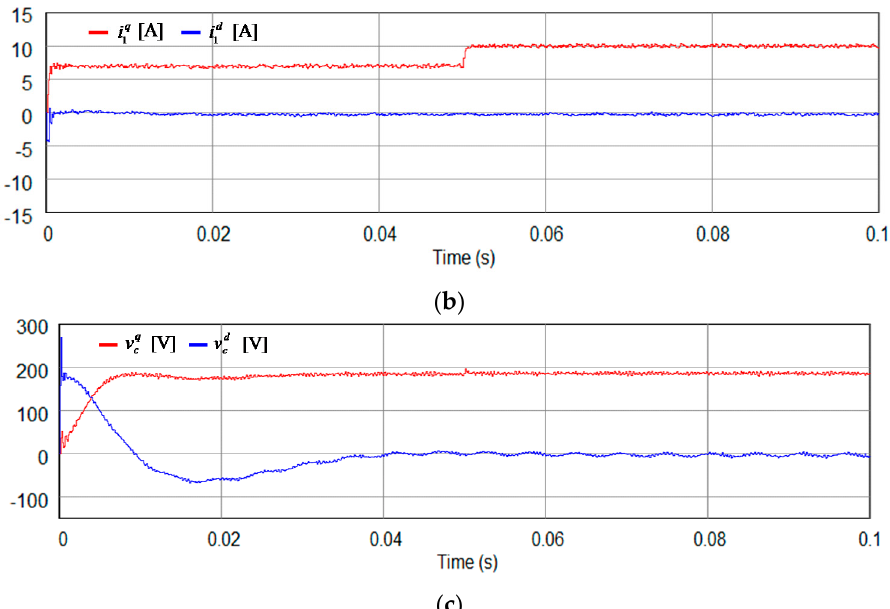
Figure 7. Simulation results for the proposed discrete-time integral state feedback control scheme with state observer under the step change in q -axis current reference. ( a ) Current references and grid-side current responses at the SRF; ( b ) Inverter-side current responses at the SRF; ( c ) Capacitor voltage responses at the SRF.